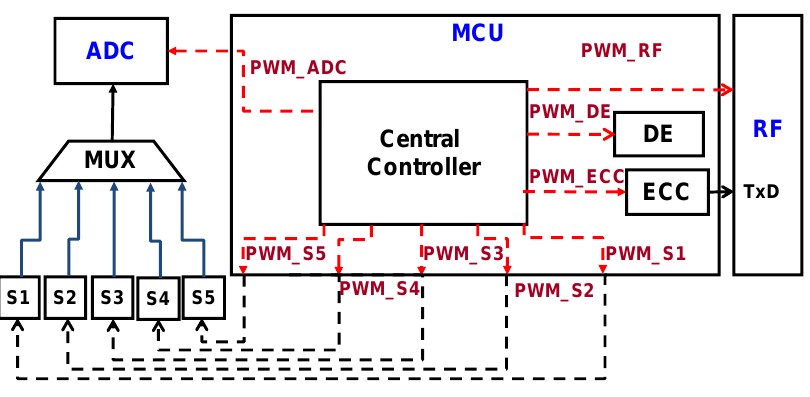
Figure 3. PWM control path for all